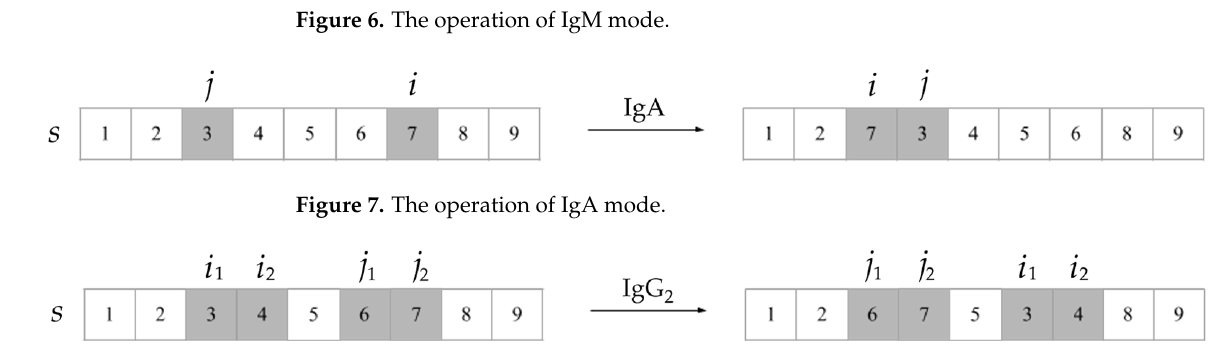
Figure 8. The operation of IgG 2 mode.